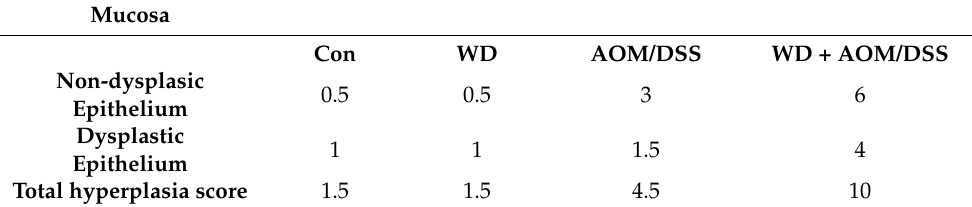
Table 5. Hyperplasia scores.